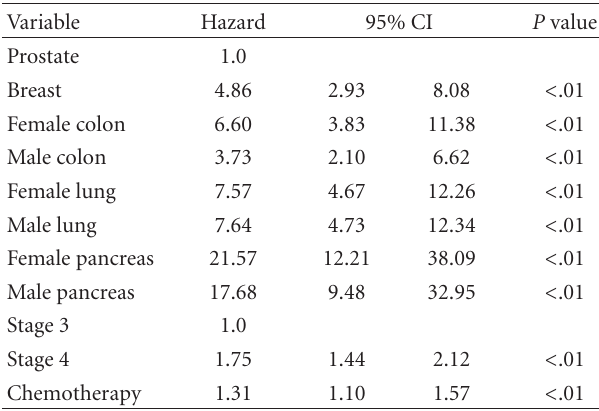
Table 3: Factors associated with developing a VTE within one year of cancer diagnosis: final cox proportional hazards